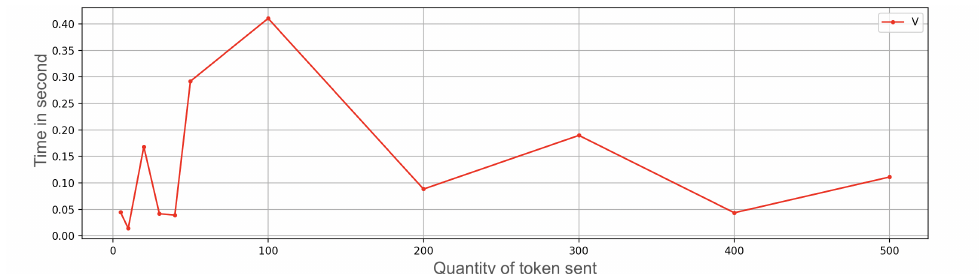
Figure 8. Exchange token time on iPhone 7 with secure enclave execution measuring variance (V) of the ramp